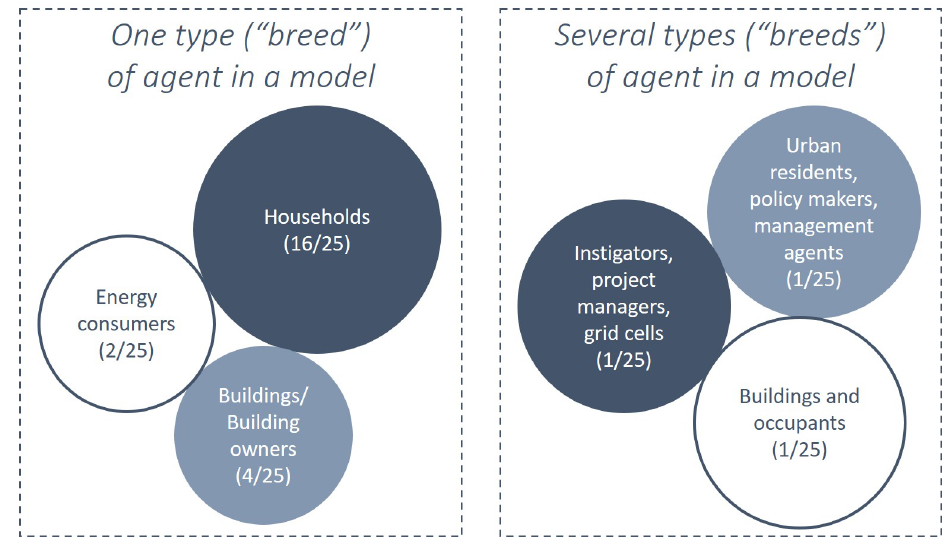
Figure 4. Agents in the reviewed models.